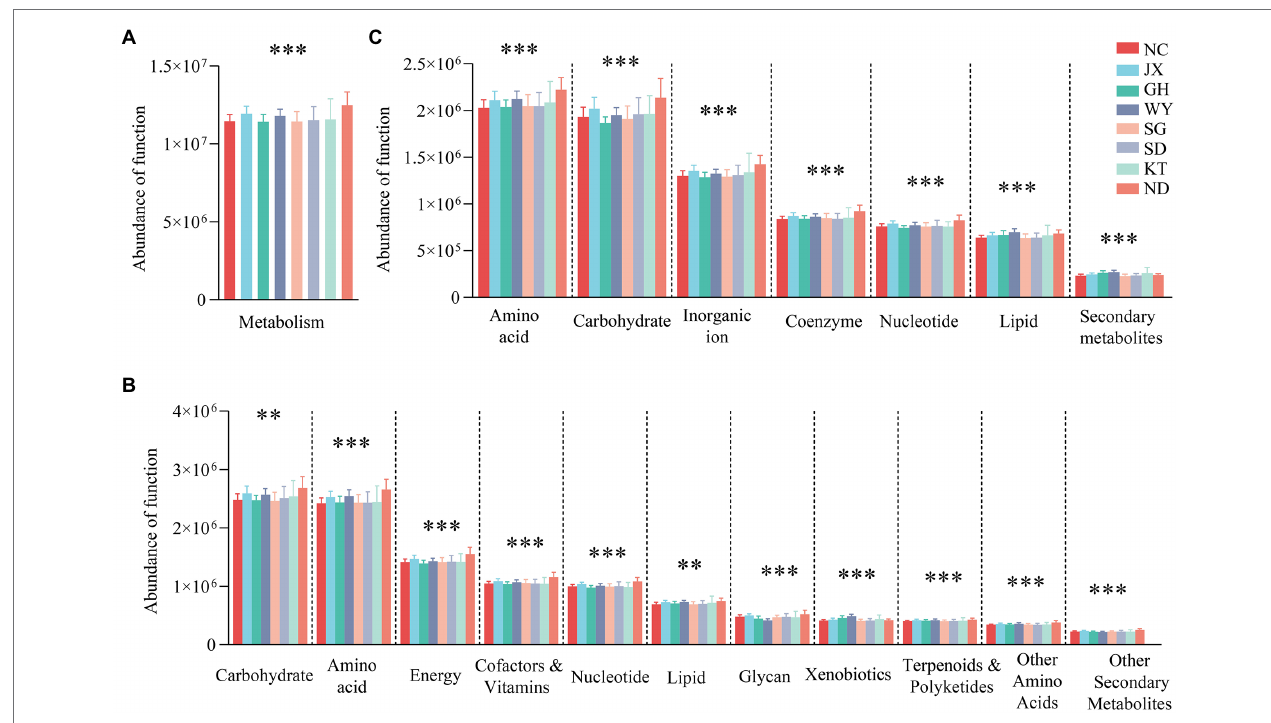
FIGURE 6 | Analysis of the differences in metabolic functions between the groups based on the KEGG database at level 1 (A) , level 2 (B) and EggNOG database (C) . ** p < 0.01; and *** p <